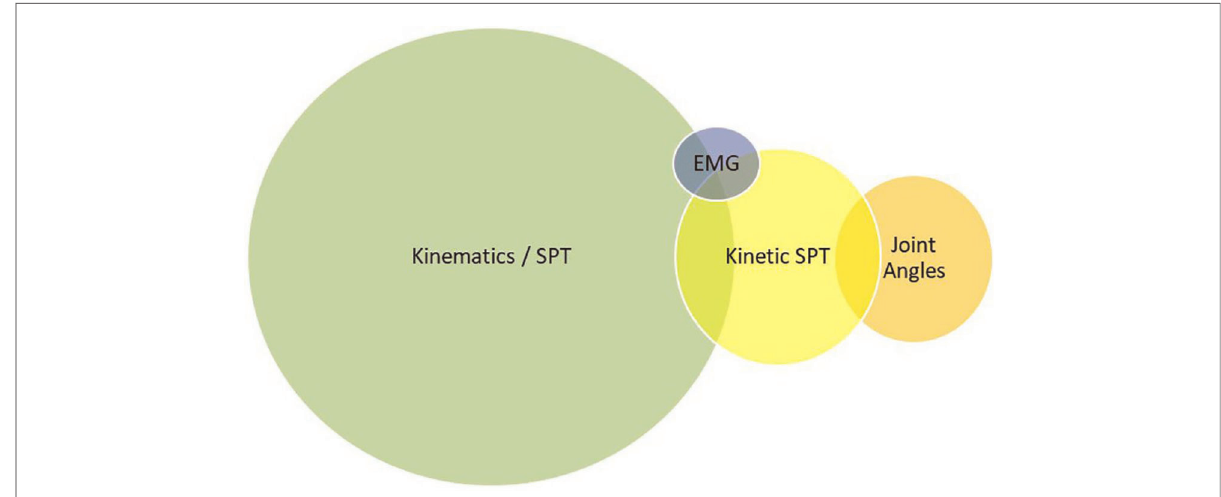
FIGURE 3 Technology results described by metrics measured within a Venn diagram demonstrating several technologies measuring more than one metric category (12%). Kinematics and SPT measures were used the most in 54 technologies (64.3%), kinetics and SPT measures were used in 16